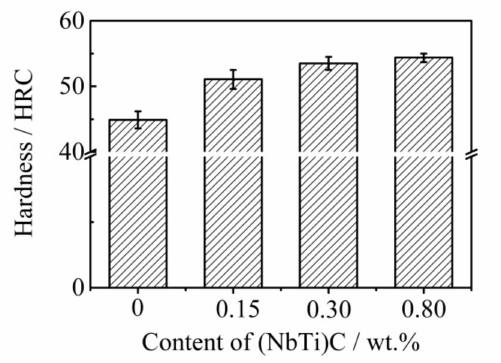
Figure 6. Hardness of the ICCI with different (NbTi)C particle